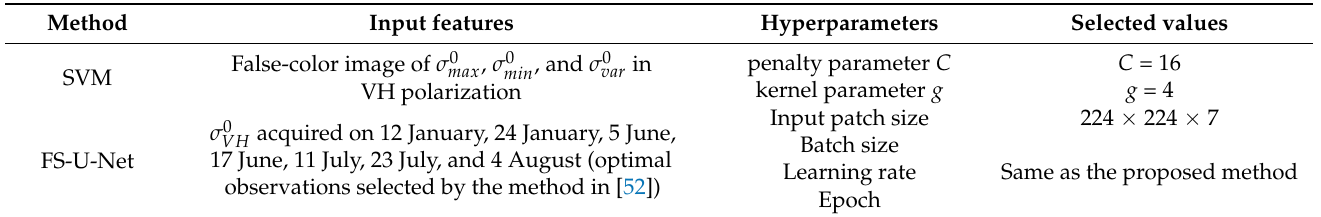
Table 5. The accuracies of Thailand paddy rice mapping